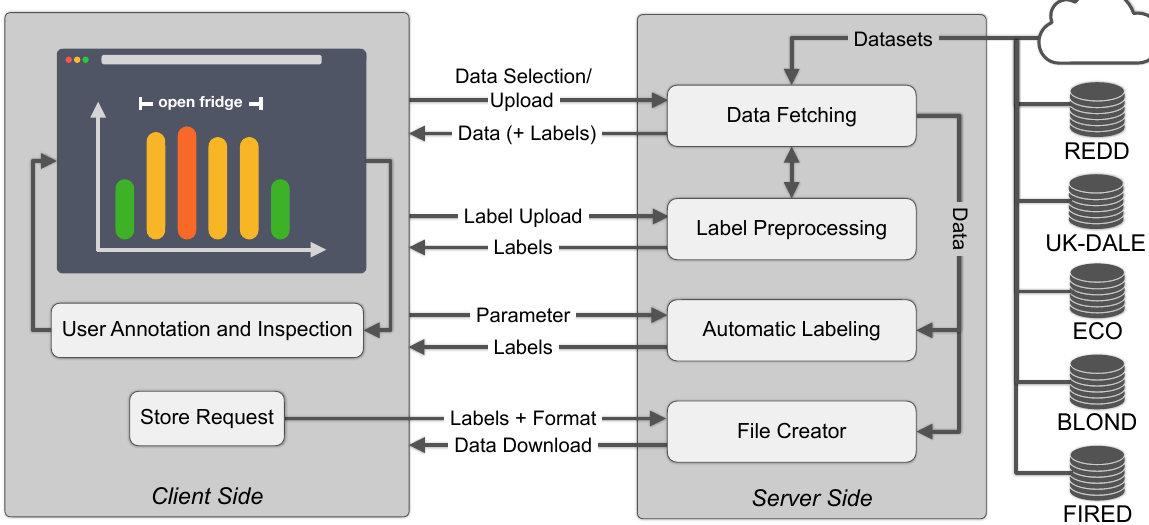
Figure 4. Flow of the Annoticity labeling tool. Data fetching, automatic labeling, and file creation are performed on the server side, while labeling and user interaction is performed on the client side (modified from